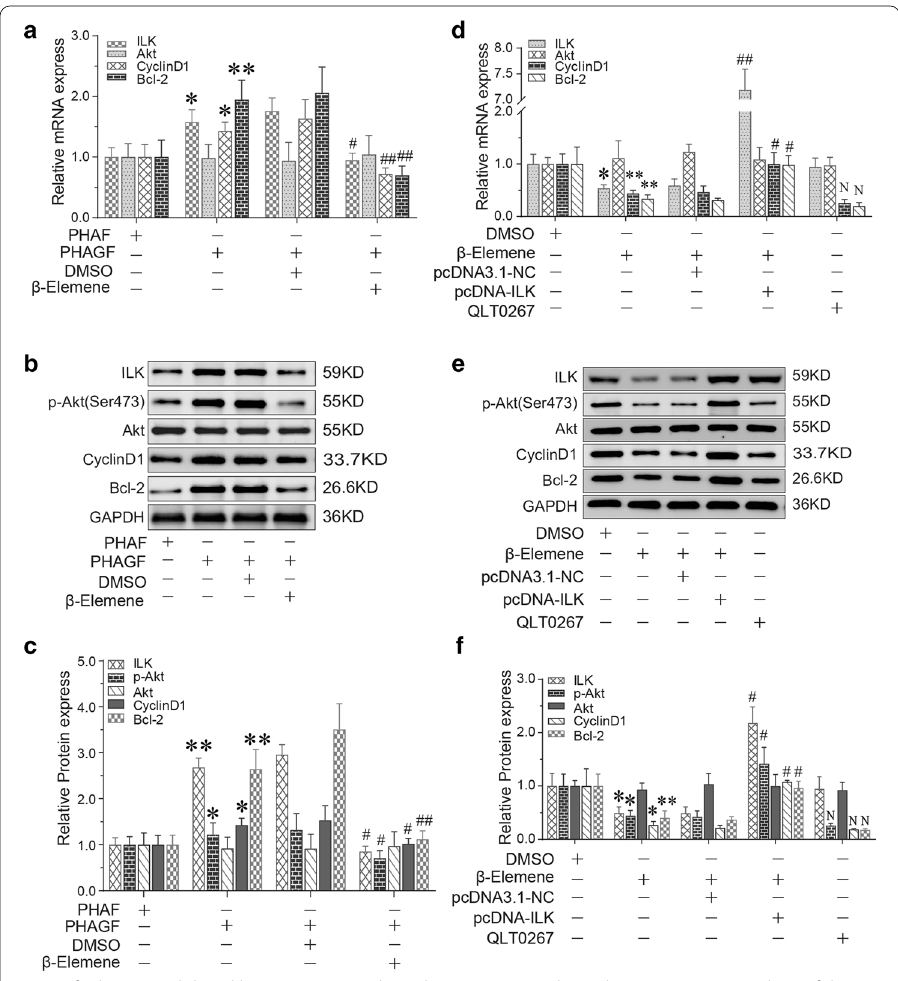
Fig. 2 β-Elemene inhibited hyperactive ILK/Akt pathway in PHAGF through ILK. a RT-qPCR analysis of the ILK/Akt pathway-related mRNA expression in PHAF, PHAGF and β-elemene-treated PHAGF; b , c Western blotting analysis of the ILK/Akt pathway-related proteins’ expression in PHAF, PHAGF and β-elemene-treated PHAGF; * P < 0.05, ** P < 0.01, versus the PHAF group; # P < 0.05, ## P < 0.01, versus the PHAGF (solvent control). d RT-qPCR detection of the transfection efficiency of pcDNA3.1-ILK and to detect the effects of pcDNA3.1-ILK or the pathway inhibitor QLT0267 on expression of ILK/Akt pathway-related mRNAs; e , f Western blotting detection of the ILK/Akt pathway-related protein expression after ILK over-expression or adding the pathway inhibitor QLT0267 in the presence of β-elemene. * P < 0.05, ** P < 0.01, versus the PHAGF DMSO group; # P < 0.05, ## P < 0.01, versus the β-elemene + versus the β-elemene